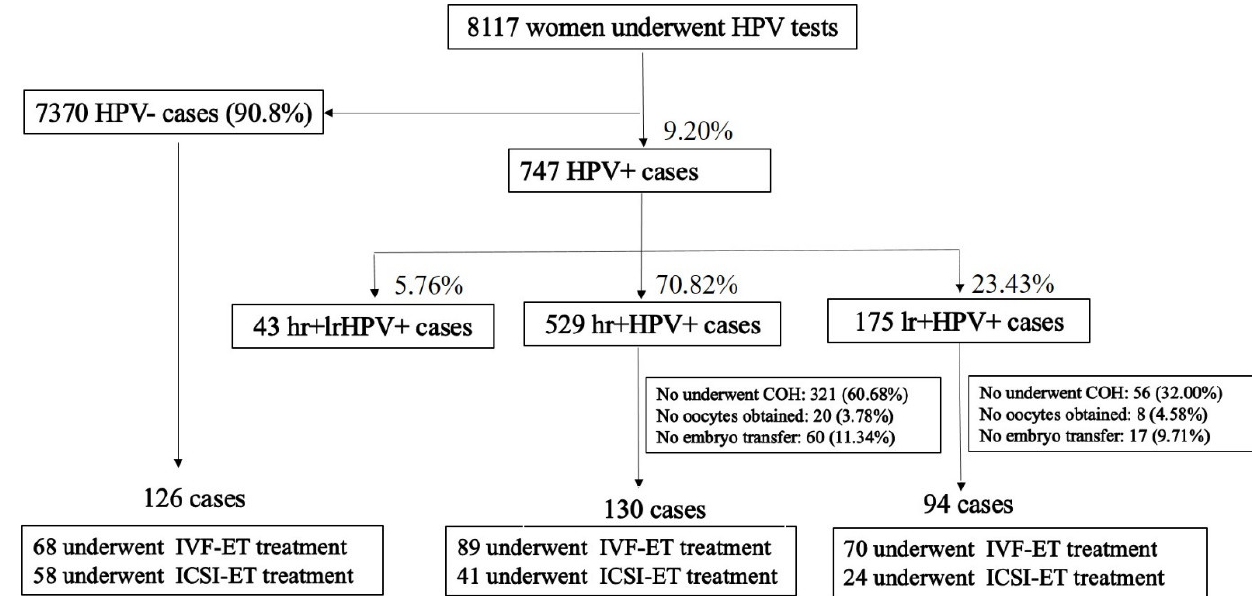
Figure 1. Study flowchart of HPV tests in women and IVF/ICSI-ET treatments. hrHPV, high-risk HPV; lrHPV, low-risk HPV; COH, controlled ovarian hyperstimulation; IVF, in vitro fertilization; ICSI, intracytoplasmic sperm injection; and ET, embryo transfer.